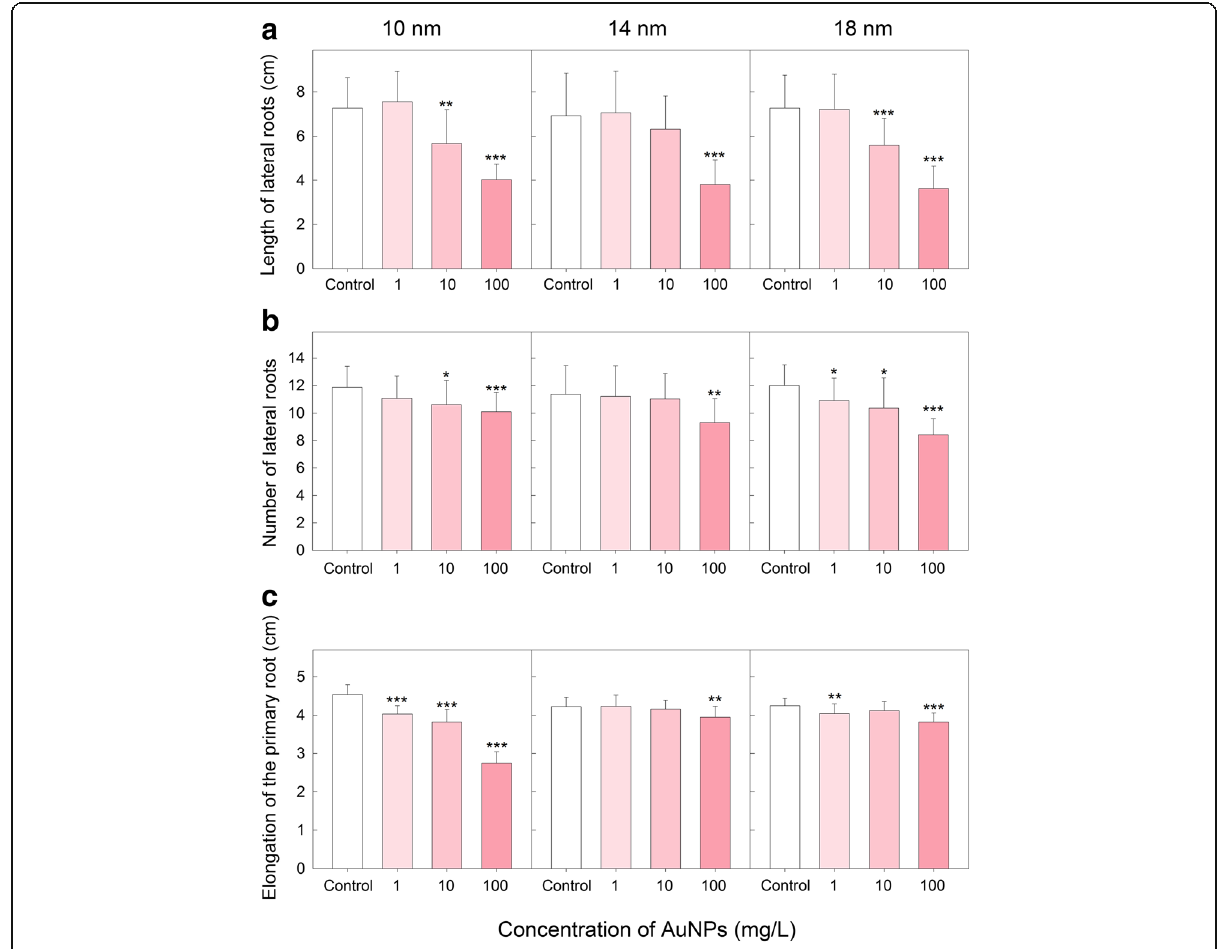
Fig. 3 Effect of AuNPs on a length and b number of lateral roots and c elongation of the primary root of A. thaliana seedlings. Plants were exposed to different concentrations (0.1, 10, and 100 mg/L) of 10, 14, and 18 nm AuNPs. Data are means +SD of 19 – 20 plants. * P <0.05, ** P <0.01, *** P <0.001; t